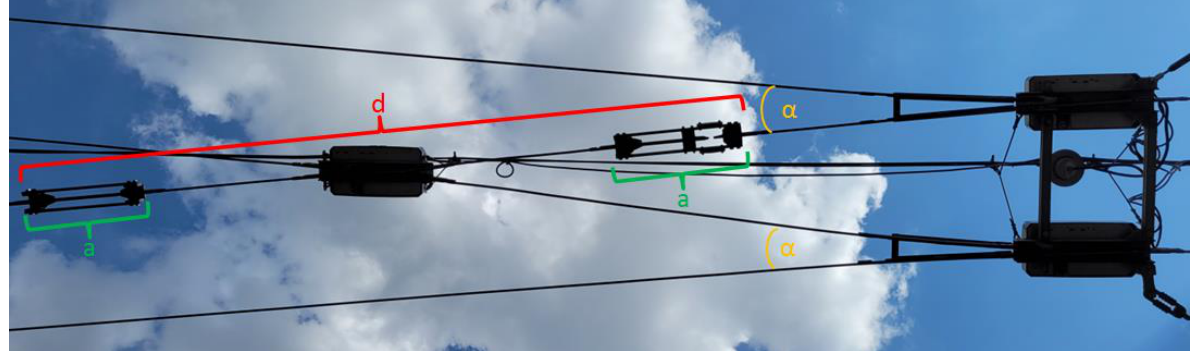
Figure 1. View of a trolleybus wire switch, showing the section of the network with no power supply, where: a denotes insulator zones and d denotes a dead zone.